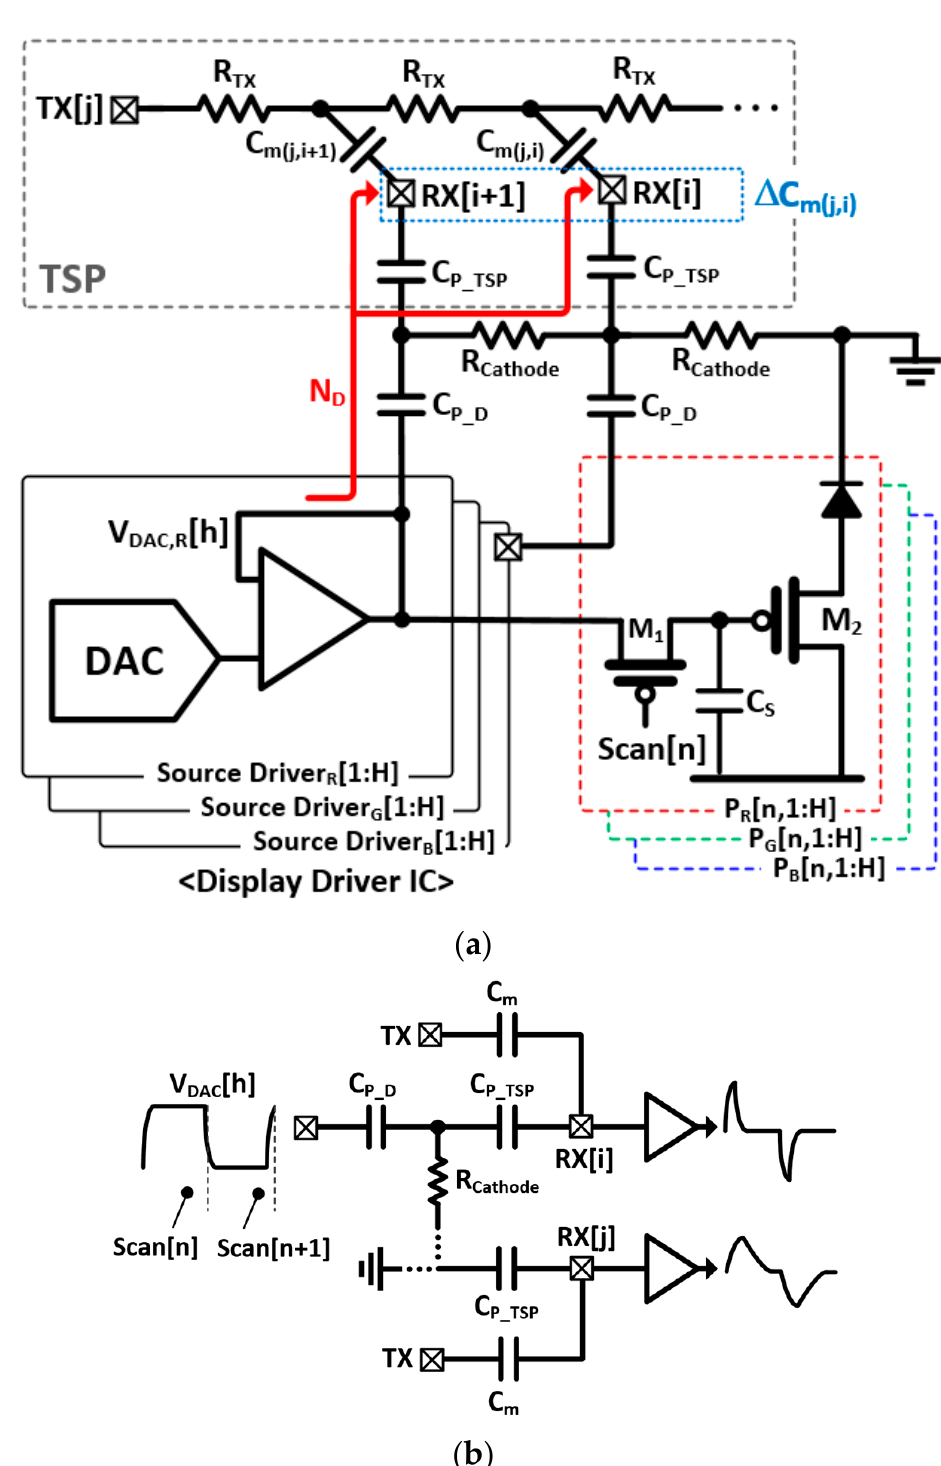
Figure 2. ( a ) Equivalent circuit model of DDI, TSP, and AMOLED pixels and ( b ) simplified model illustrating display noise injection.